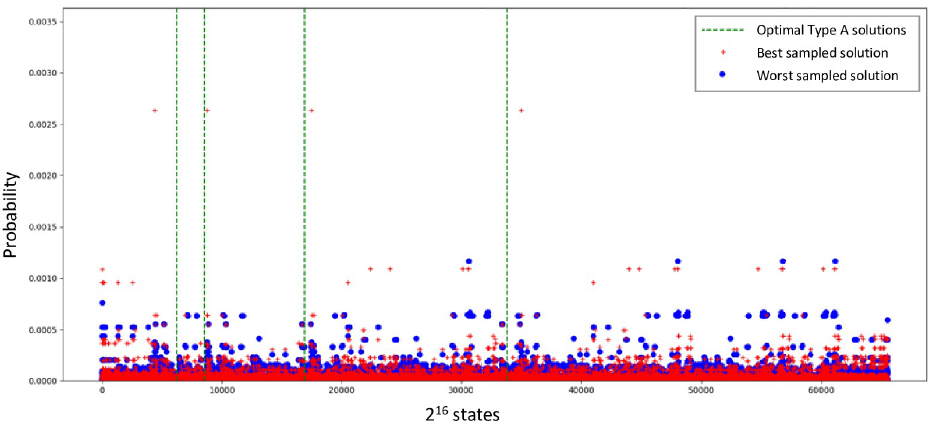
Fig 9. Result of simulating QuASeR example using QAOA on the QX